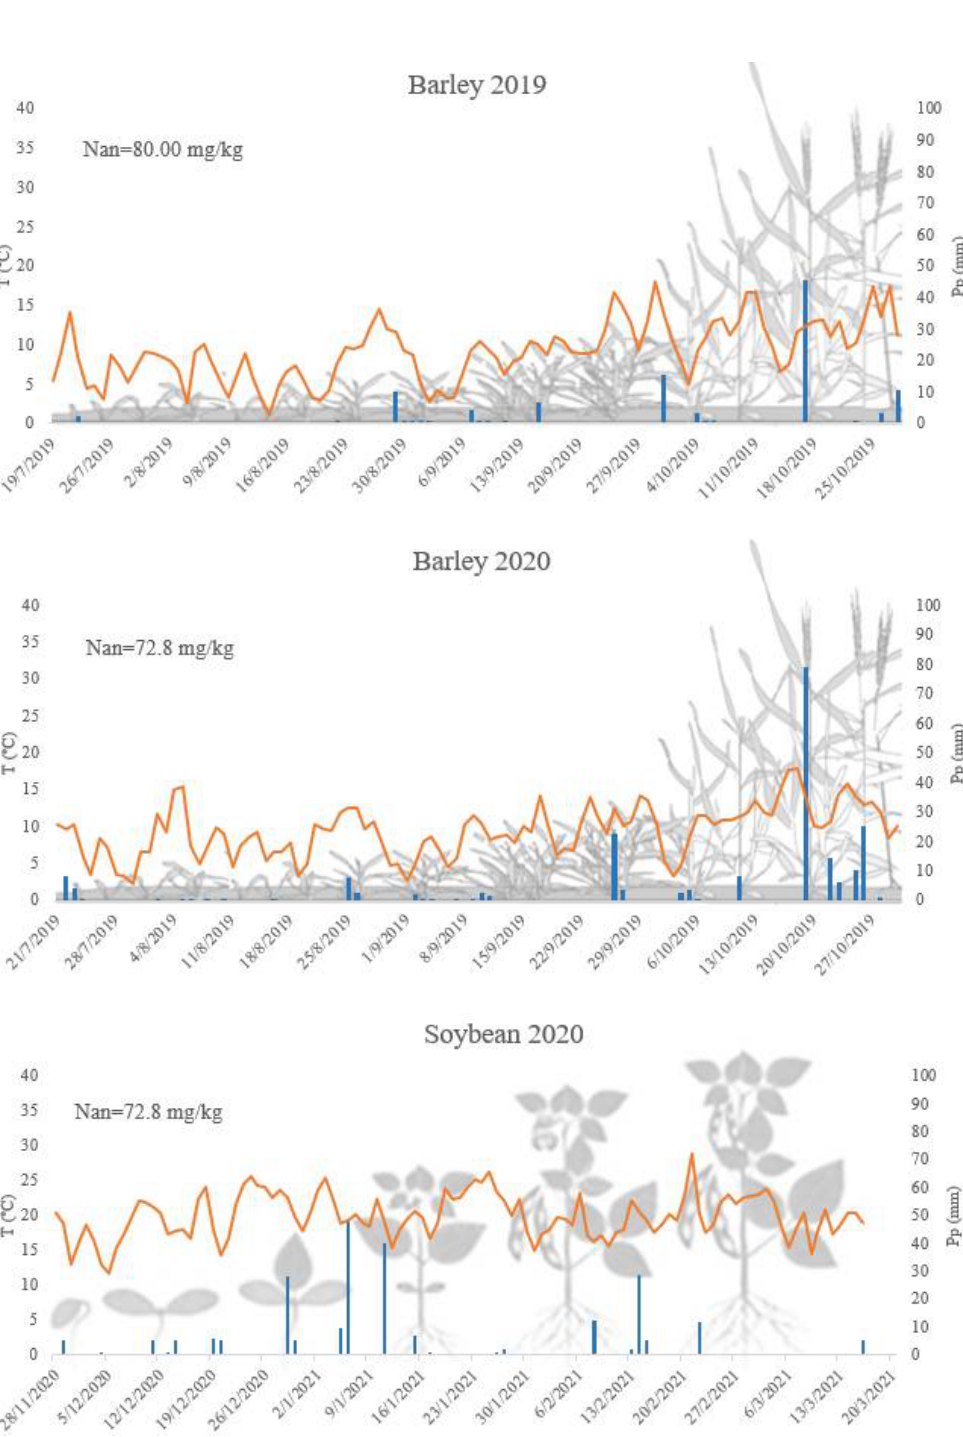
Figure 2. Anaerobic nitrogen (Nan) values and evolution of daily air temperature (T) (orange line) and daily precipitation (Pp) (blue column) during period of major nitrogen mineralisation and offtake by the crop. Illustration source: [58,59].